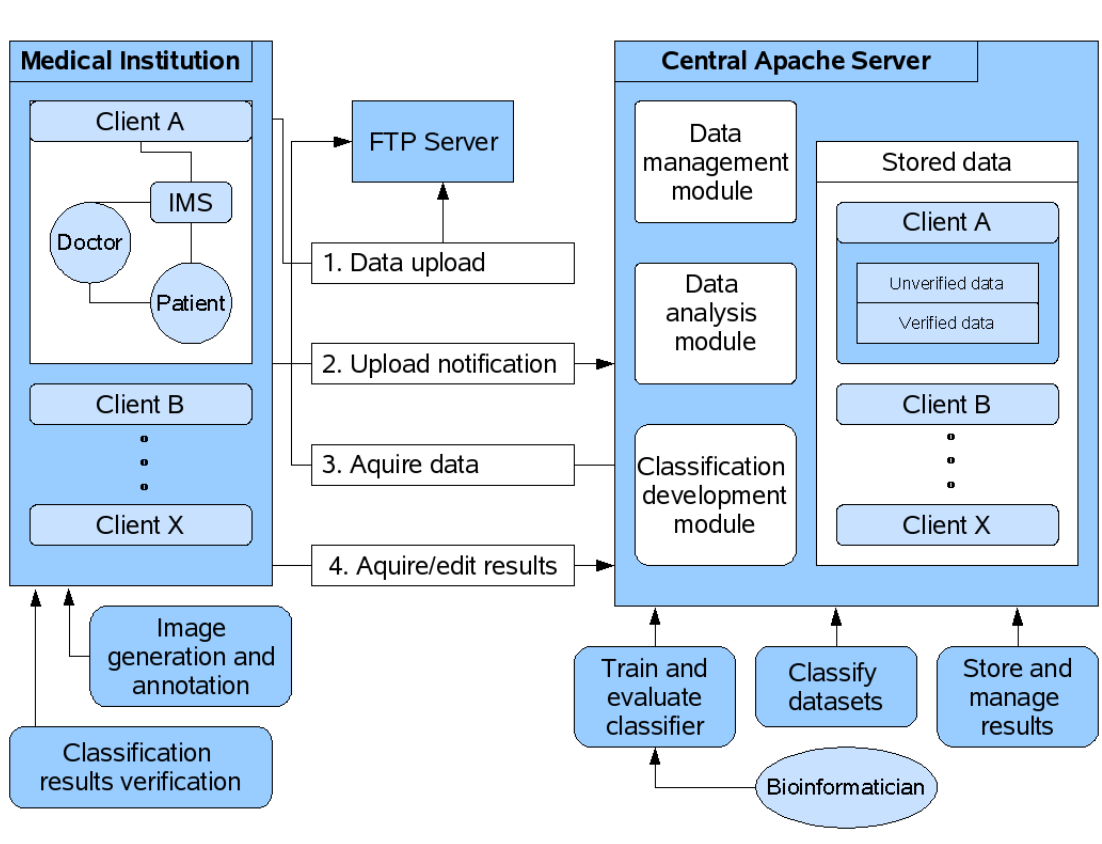
Figure 2: Schematic overview of the IMS 2 software architecture and the data